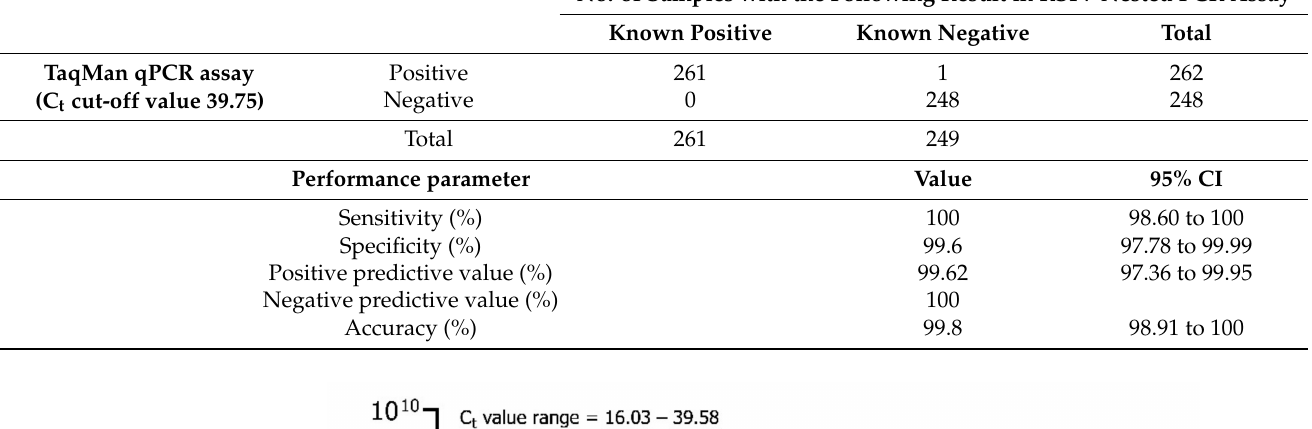
Table 3. Diagnostic performance of the TaqMan-based real-time PCR assay in comparison with the reference nested PCR assay conducted on fish samples.